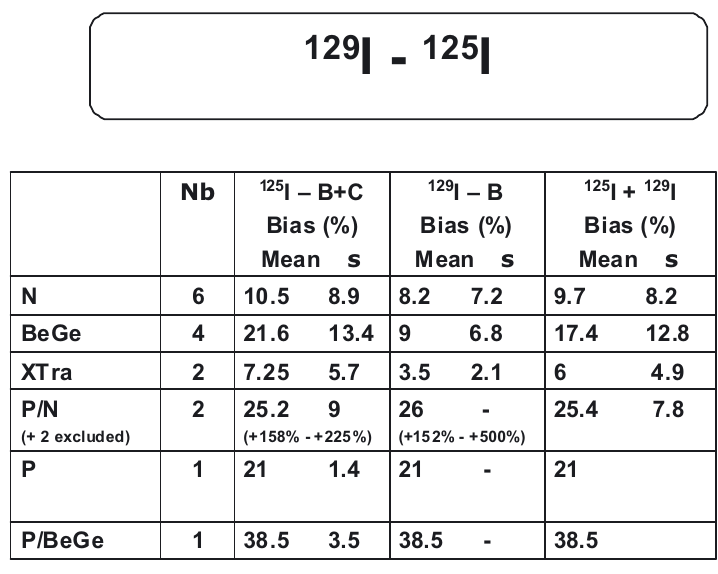
Fig. 4. Performance of the detectors for the 129 I and 125 I detection.